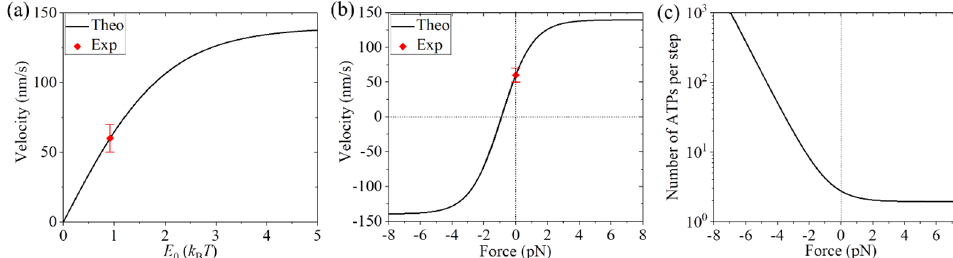
Figure 8. Dynamics of KHCNcd motors. KHCNcd represents the engineered motor consisting of the neck and NL of kinesin-1 joined to the Ncd motor domain. Lines are theoretical results. Symbols are experimental data taken from Case et al. [41]. ( a ) Velocity versus E 0 under no load. ( b ) Velocity versus backward and forward loads. ( c ) Number of ATPs consumer per step versus backward and forward loads.